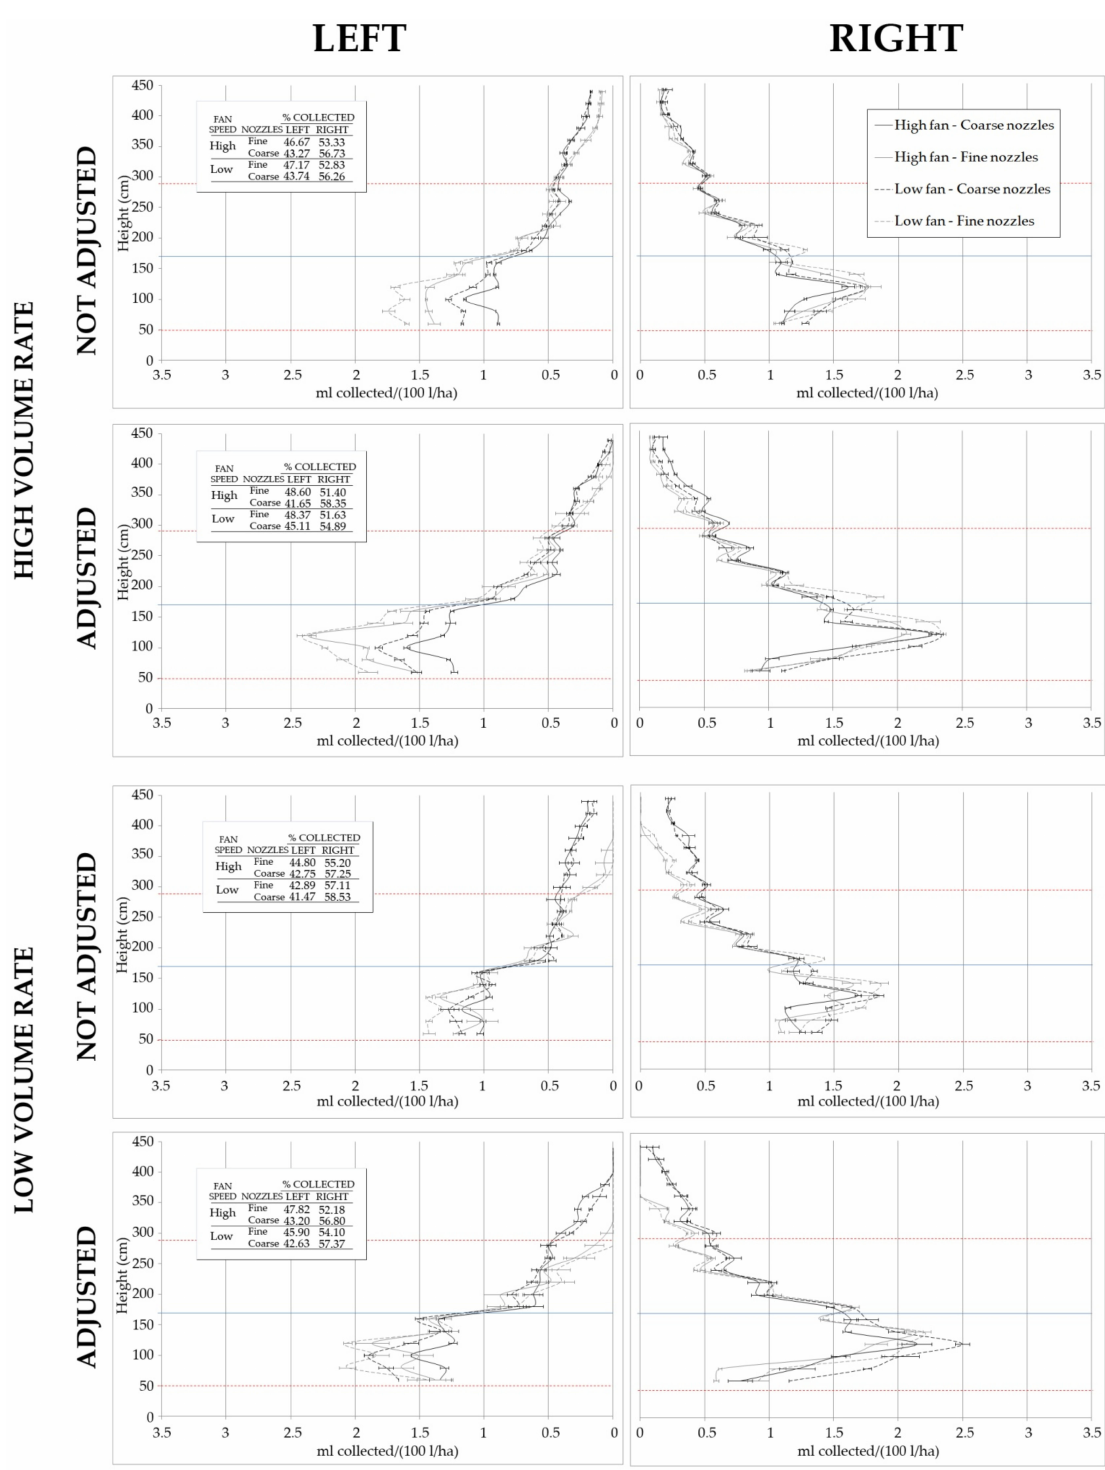
Figure 9. Vertical spray profiles showing the normalized volume collected by the patternator (mL/(100 L/ha) (mean ± SE) at different heights above the ground (m), for the applications with the C1 sprayer . The percentage collected on each side of the sprayer respect to the total volume collected for each configuration is shown. The red dashed lines represent the upper and the lower limit of the canopy, and the blue line its middle